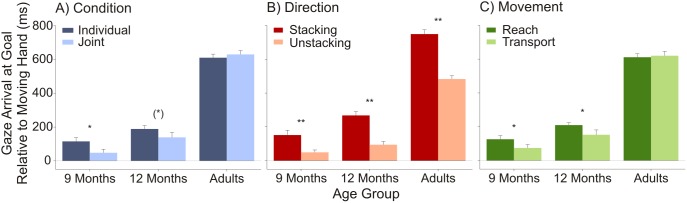
Mean gaze latency towards goals for all age groups.Mean gaze latencies are illustrated (A) in both experimental conditions, (B) for stacking direction, and (C) for movement type (with standard errors). Grey line at zero displays arrival of the hand at goal areas. Positive values indicated that gaze was anticipatory. Asterisks denote difference between a) individual and joint conditions, b) the two different directions, and c) both movement types (**: p<.01; *: p<.05; (*): p<.10).